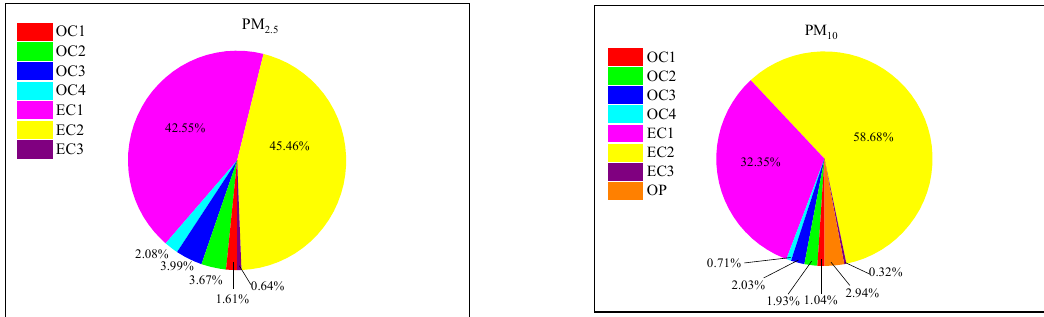
Figure 2. The mass fractions of eight carbonaceous components in total carbon of PM 10 and PM 2.5 from carbon plant.